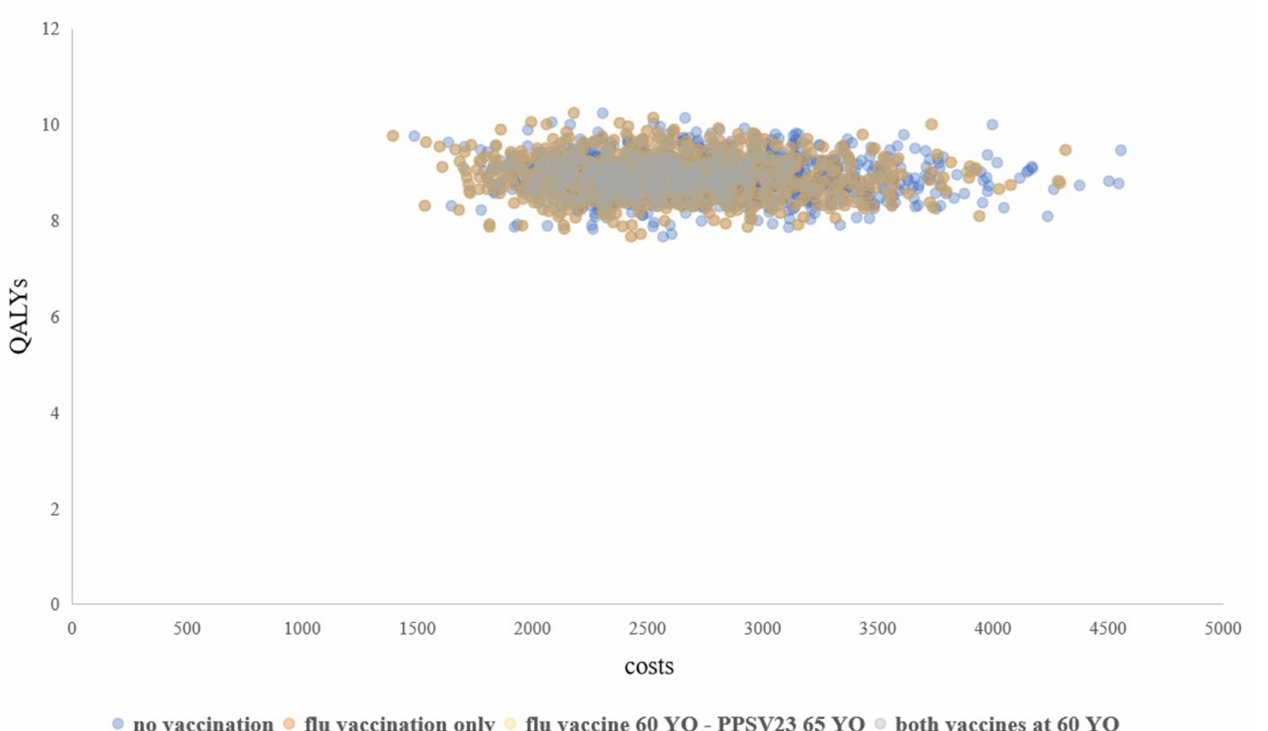
Figure 3. The scatterplots of QALYs against costs associated with the four strategies from the PSA. QALY, quality-adjusted life year; YO, years